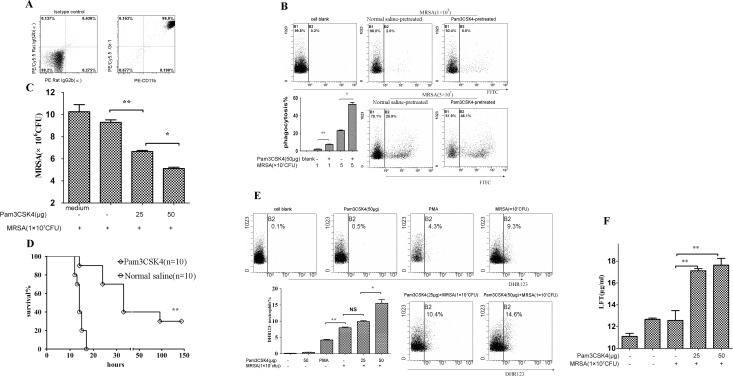
Pretreatment with Pam3CSK4 increases antimicrobial activity of neutrophils.Neutrophils were purified according to the instructions (Miltenyi,Gemany). Neutrophils were purified and measured by flow cytometry (A), and PE/CY5.5-Rat IgG2b(κ), PE-anti Rat IgG 2b(κ) as isotype controls(left panel in Fig 6A). The bacterial cfu of neutrophils was calculated (B), the left panel (the medium contol) indicated the well including MRSA and medium (RPMI1640) but Pam3CSK4 and neutrophils. FITC-positive neutrophils were quantified by flow cytometry(C). Survival of mice injected with neutrophils co-cultured with Pam3CSK4, and previously inoculated with MRSA 1 hour earlier (D). Generation of ROS was measured by flow cytometry (E) and lactoferrin release was tested using mouse Lactoferrin ELISA Kit (F). Note: *P<0.05; **P<0.01 versus normal saline-treated mice.